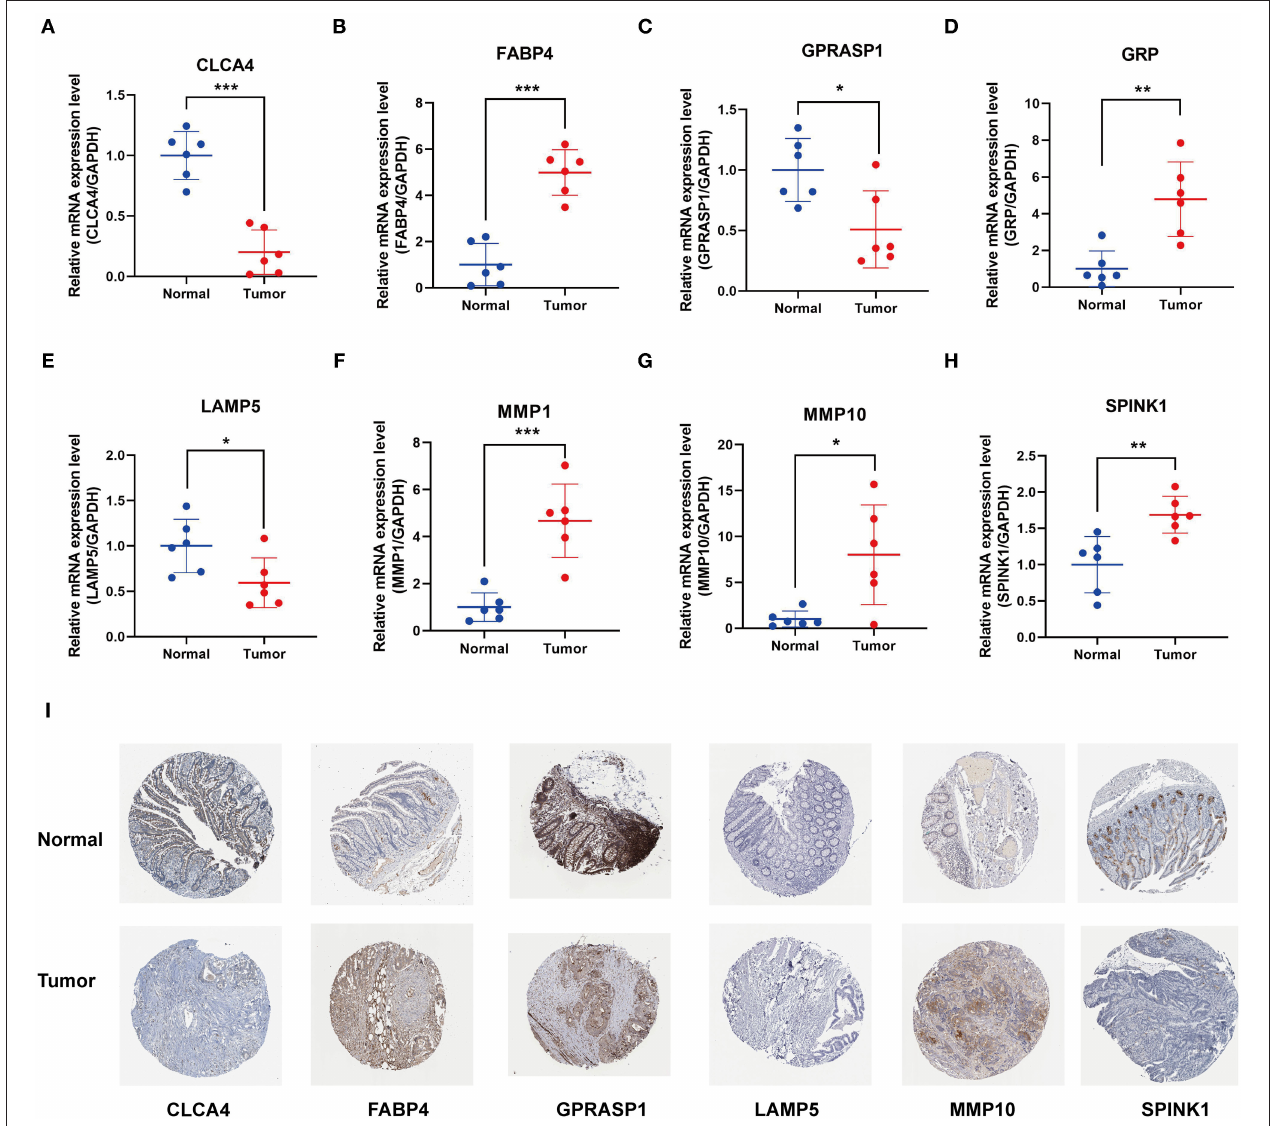
FIGURE 7 | Validation of 8 prognostic signature genes expression. (A–H) Differential expression of (A) CLCA4, (B) FABP4, (C) GPRASP1, (D) GRP, (E) LAMP5, (F) MMP1, (G) MMP10, and (H) SPINK1 in the colon cancer and adjacent tissues (* P < 0.05, ** P < 0.01, and *** P < 0.001). (I) Representative immunohistochemical staining of signature genes in the Human Protein Atlas